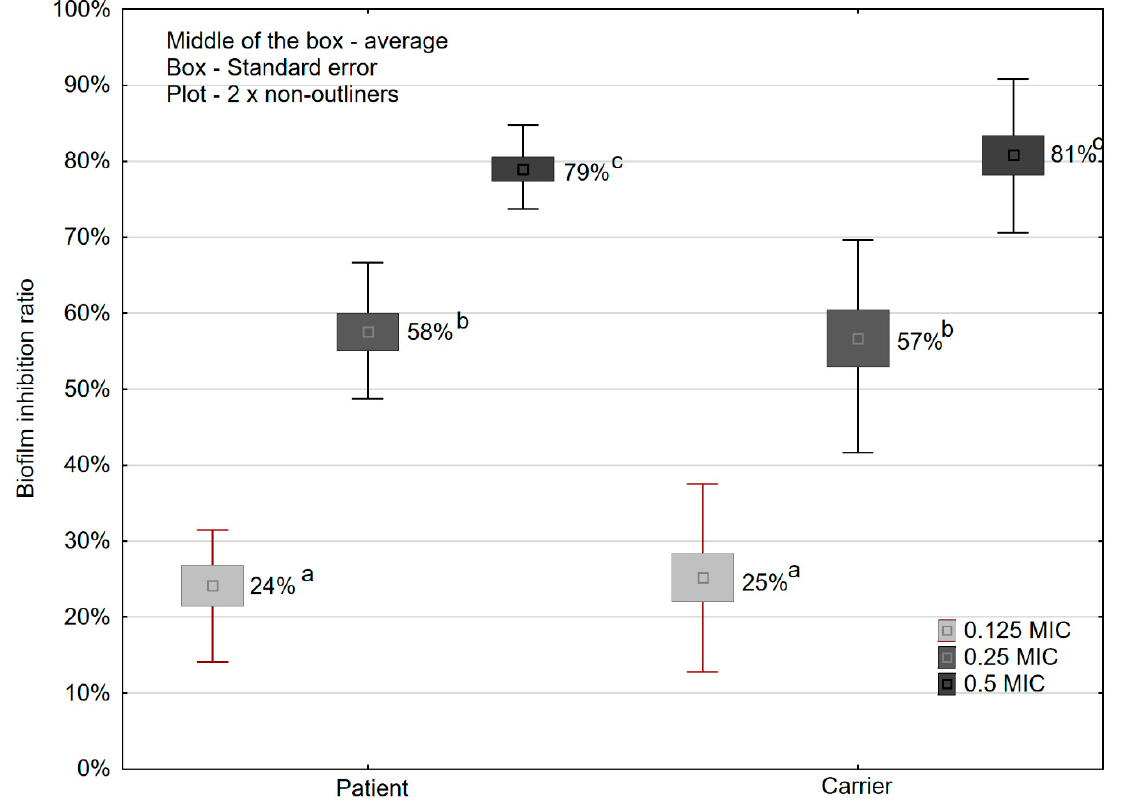
Figure 3. Ampicillin MIC values for S. enterica strains ( n = 69).